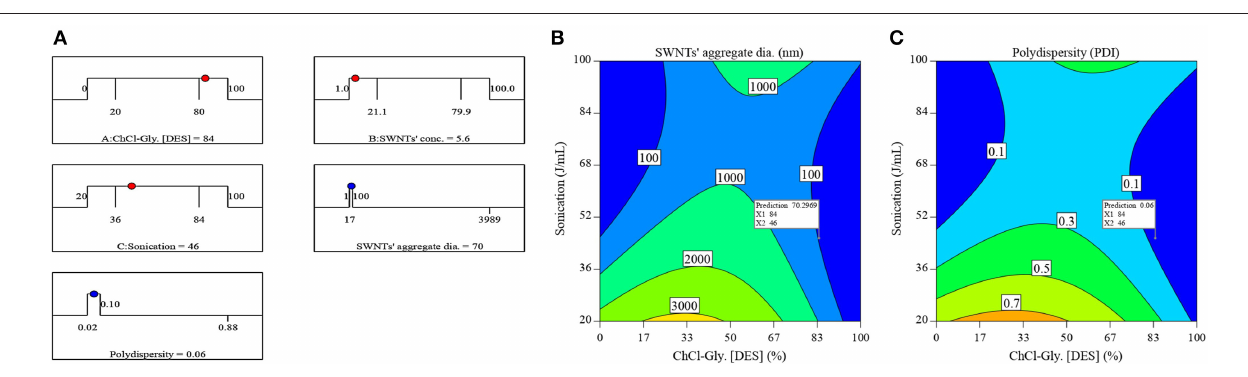
(at 50% ChCl-Gly). However, more addition of ChCl-Gly does not continuously decrease the magnitude of negative surface charge, instead, it drastically increased (from − 2.2 mV)